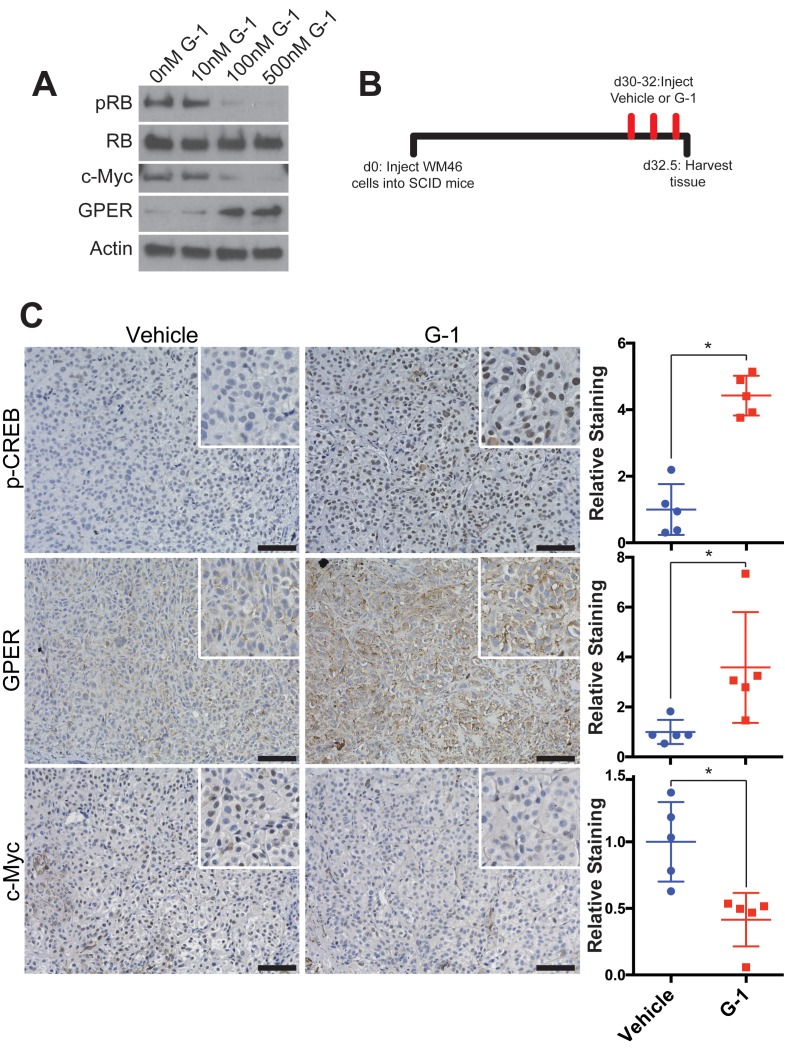
Markers of GPER activation in vivo.(A) Western blot of WM46 cells treated for 16 hr with increasing concentrations of G-1. (B) Experimental timeline of WM46-bearing mice treated with vehicle or G-1, n = 5 per group. (C) Immunohistochemistry staining of WM46 tumors treated with either vehicle or G-1 with quantification of staining on right, * denotes significance by the Mann-Whitney test. Scale bars = 100 μM.